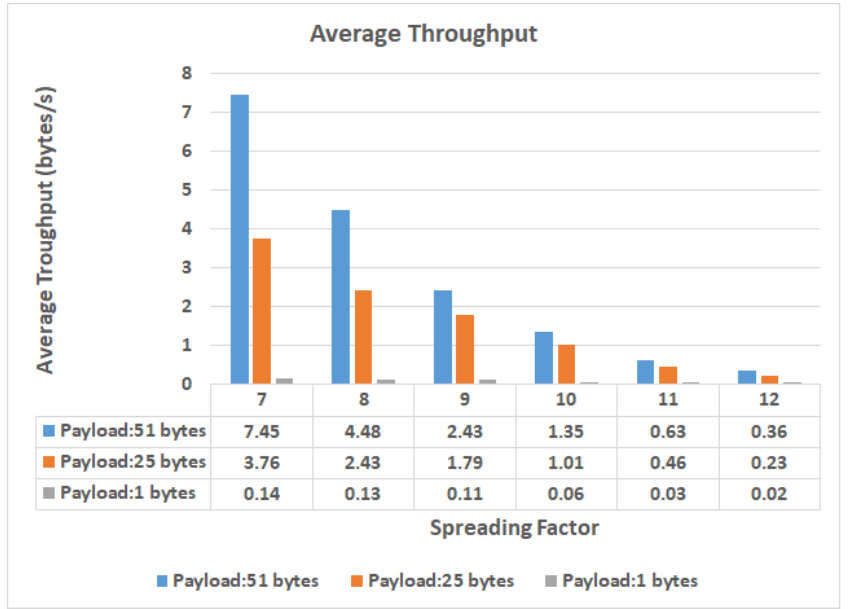
Figure 20. Average